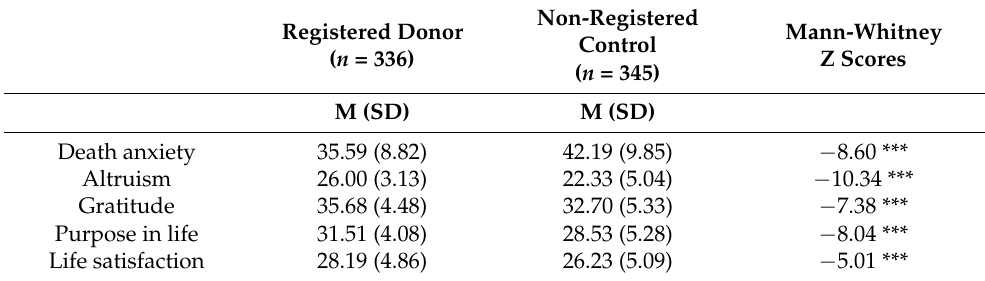
Table 3. Means and standard deviations of research variables for registered donor and non-registered control groups.